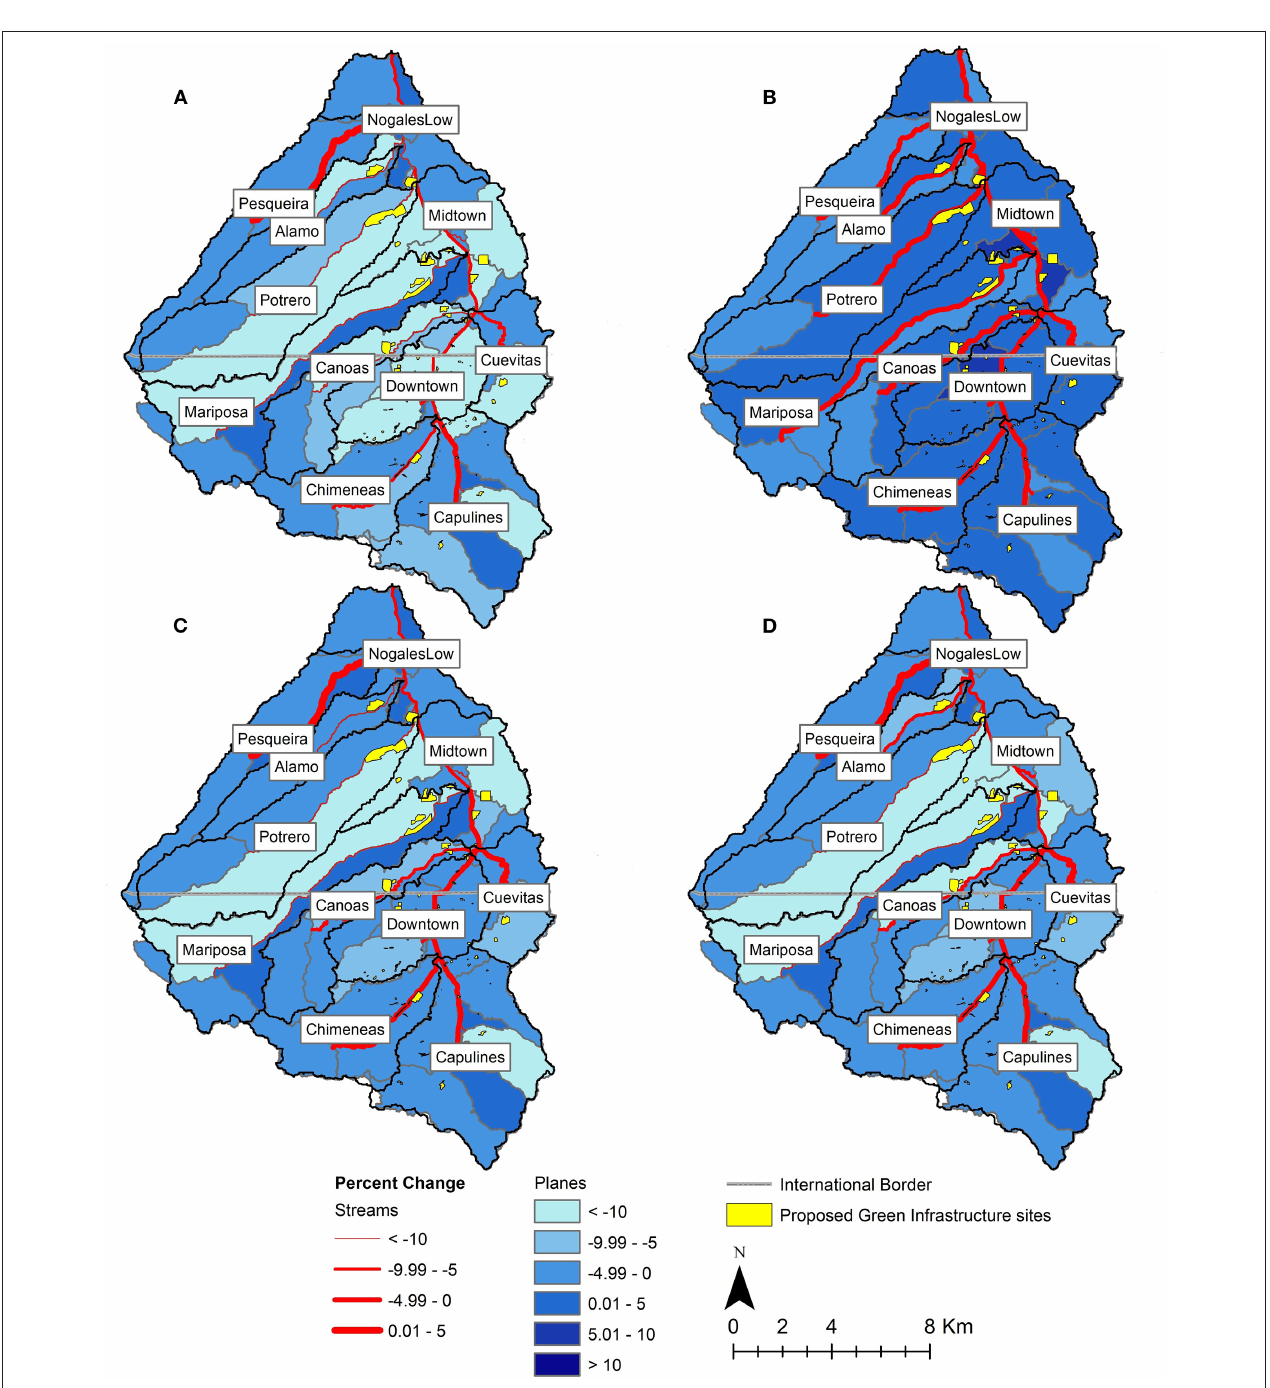
FIGURE 6 | Maps depicting percent change for planes and streams in (A) sediment yield/discharge (kg/ha, kg/s). (B) Infiltration (mm, m 3 /km). (C) Peak flow (mm/h); and (D) runoff (m 3 ) after implementation of green infrastructure.